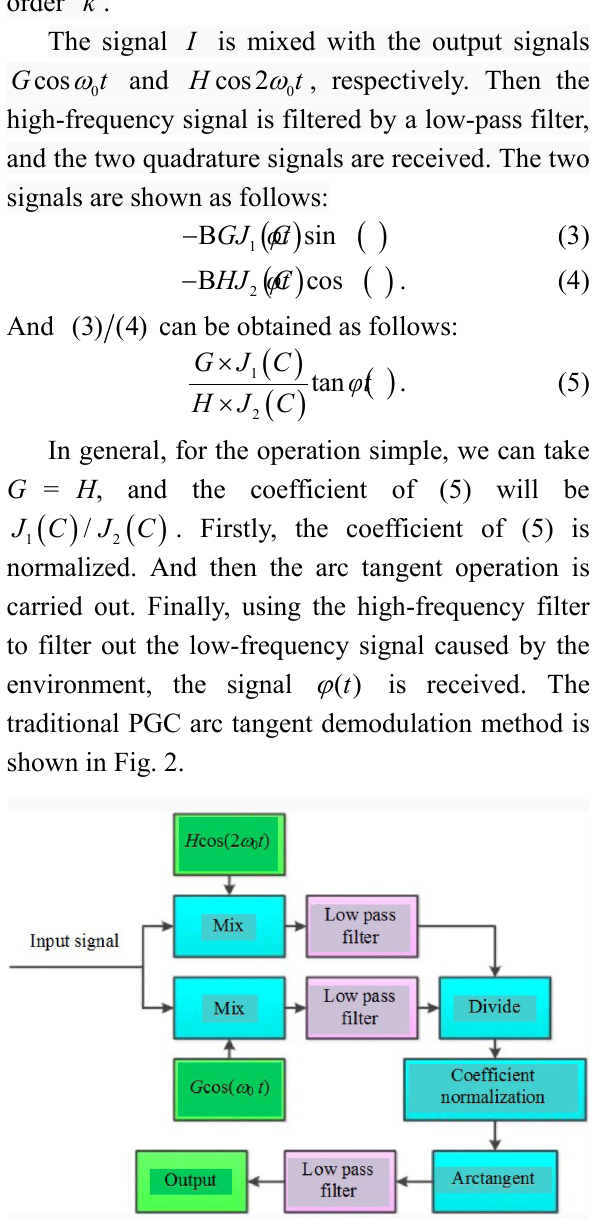
Fig. 2 Schematic of the PGC arc tangent demodulation